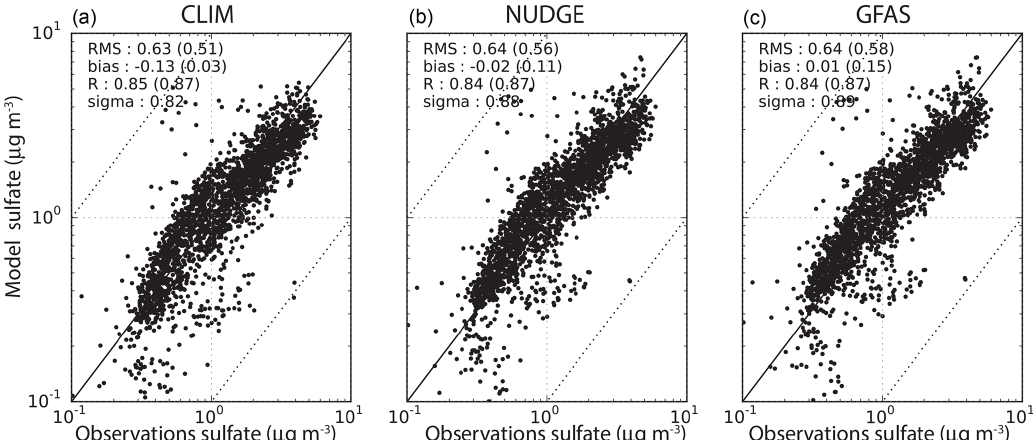
Figure 11. Scatterplot of sulfate surface concentrations from the EMEP and IMPROVE networks and from the CLIM (a) , NUDGE (b) , and GFAS (c) simulations. Model data were selected for days when observations were available at each station location and yearly averaged. Observed and collocated simulated averages for all available stations (see Fig. 2 for the location of the stations) were compared for the years 2003 to 2012 for IMPROVE and EMEP stations. For each comparison the root mean square error (RMS; with normalized RMS in parentheses), the correlation coefficient ( R , shown on log scale in parentheses), the absolute bias (normalized bias), and the ratio between simulated and observed standard deviation (sigma) are